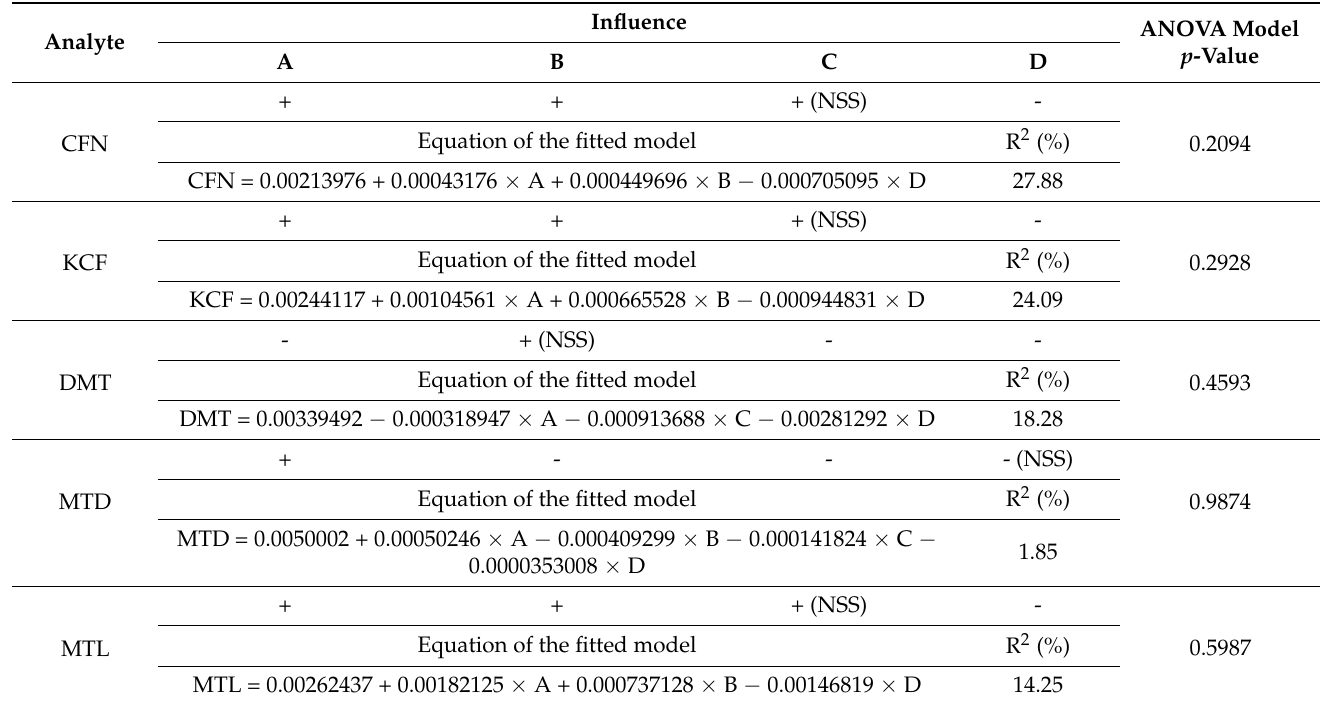
Table 6. Summary of the multifactorial multiple regression analysis for the analytes under study and their experimental variables, using CCCA, and mechanical agitation for